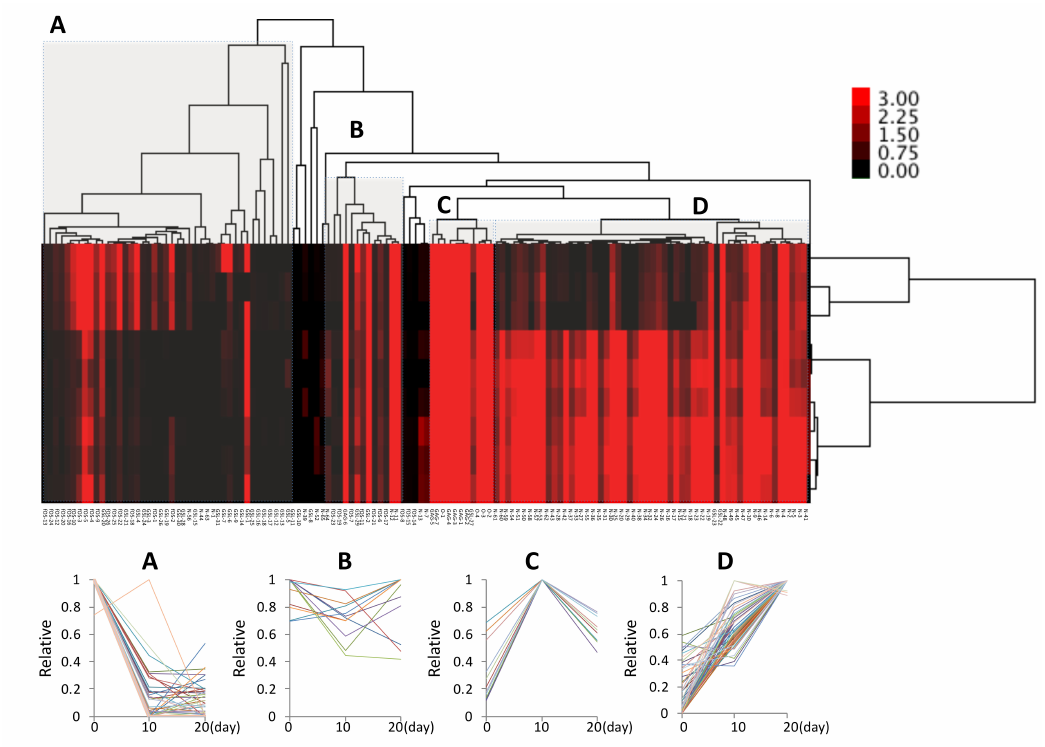
Figure 3. Classification of cells and glycans based on unsupervised cluster analysis. The absolute amount of each glycan (pmol / 100 µ g of protein) was analyzed using Cluster 3.0 Software. The relative abundance and the amount of each glycan (classified into Group A, B, C, or D) is shown in Table S1 and Figure